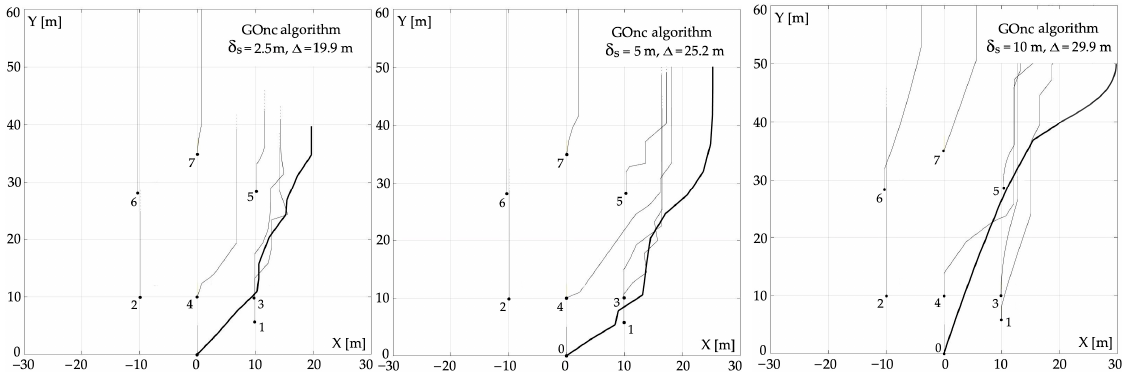
Figure 14. Safe game trajectory of our autonomous vehicle in one-way traffic when passing seven other non-cooperating autonomous vehicles for three safe passing distance values.